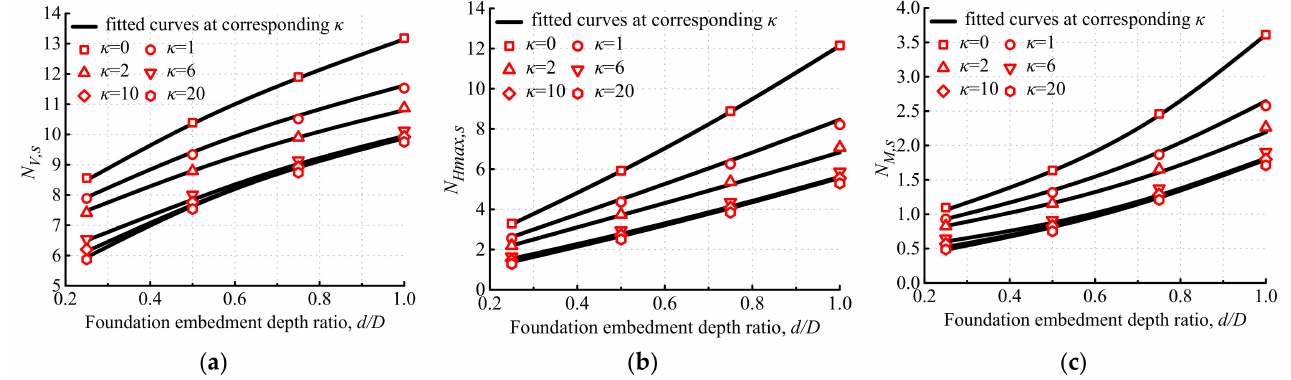
Figure 5. Comparisons of capacity factors for the single bucket foundation between finite-element results and fitted curves: ( a ) vertical capacity factor, ( b ) maximum horizontal capacity factor and ( c ) moment capacity